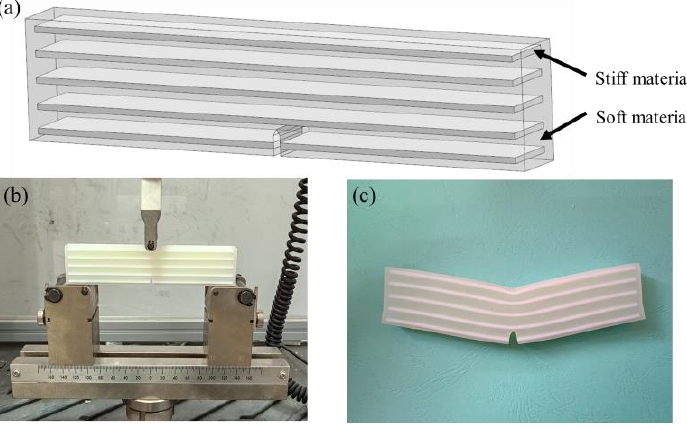
Figure 20. Experimental test of the reference sample. ( a ) Laminated model ( b ) Three-point bending experiment of conventional laminated structure ( c ) Experimental results of laminated structure.